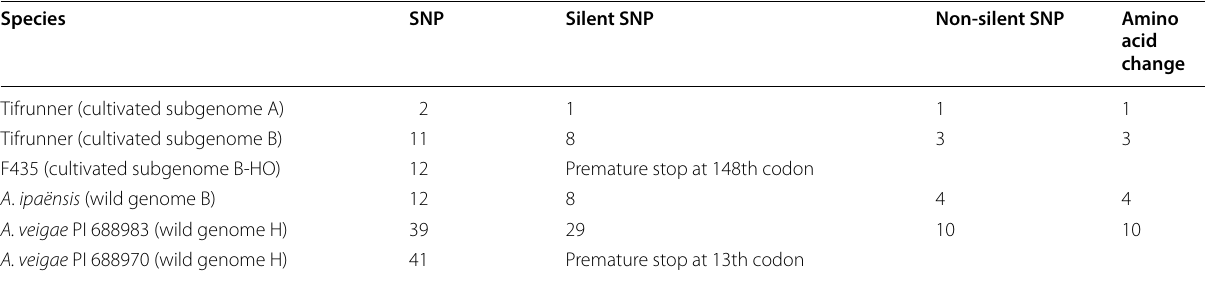
Table 2 Comparison of the sequences of FAD2 coding region and amino acid changes among selected cultivated and wild peanut species